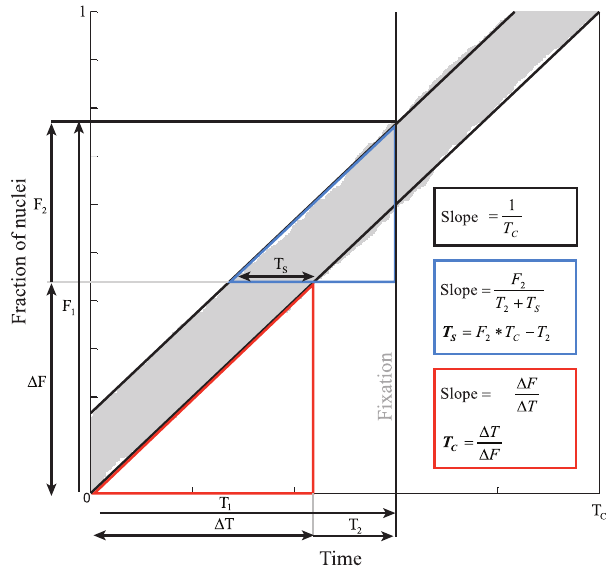
Figure 1. Graph to illustrate the differential exposure time theorem. The graph is based on a simulation of 500 nuclei with a fixed S-phase length and cell cycle length randomly entering S-phase. The S- phases are then sorted and plotted in gray. The Y-axis has a length of 1 (all cells) and the X-axis has a length of one cell cycle (T C ). The slope of the line formed by the end points of the S-phases is therefore by definition 1/T C . Thymidine analogues are incorporated into the nucleus during the S-phase (between the black lines). The fraction of labelled nuclei is thus determined by the length of the S-phase plus the time of exposure to the thymidine analogue divided by the total length of the cell cycle [7]. When two different exposure times are applied, either by two different thymidine analogues or in two different animals, the difference in fraction of labelled nuclei ( D F) is linearly related to the difference in exposure time ( D T) (red triangle). Because the slope of this relation is equal to 1/T C , the cell cycle length can be calculated (red box). Similarly, the length of the S-phase can be determined from the slope in the blue triangle and the calculated T C (blue box).